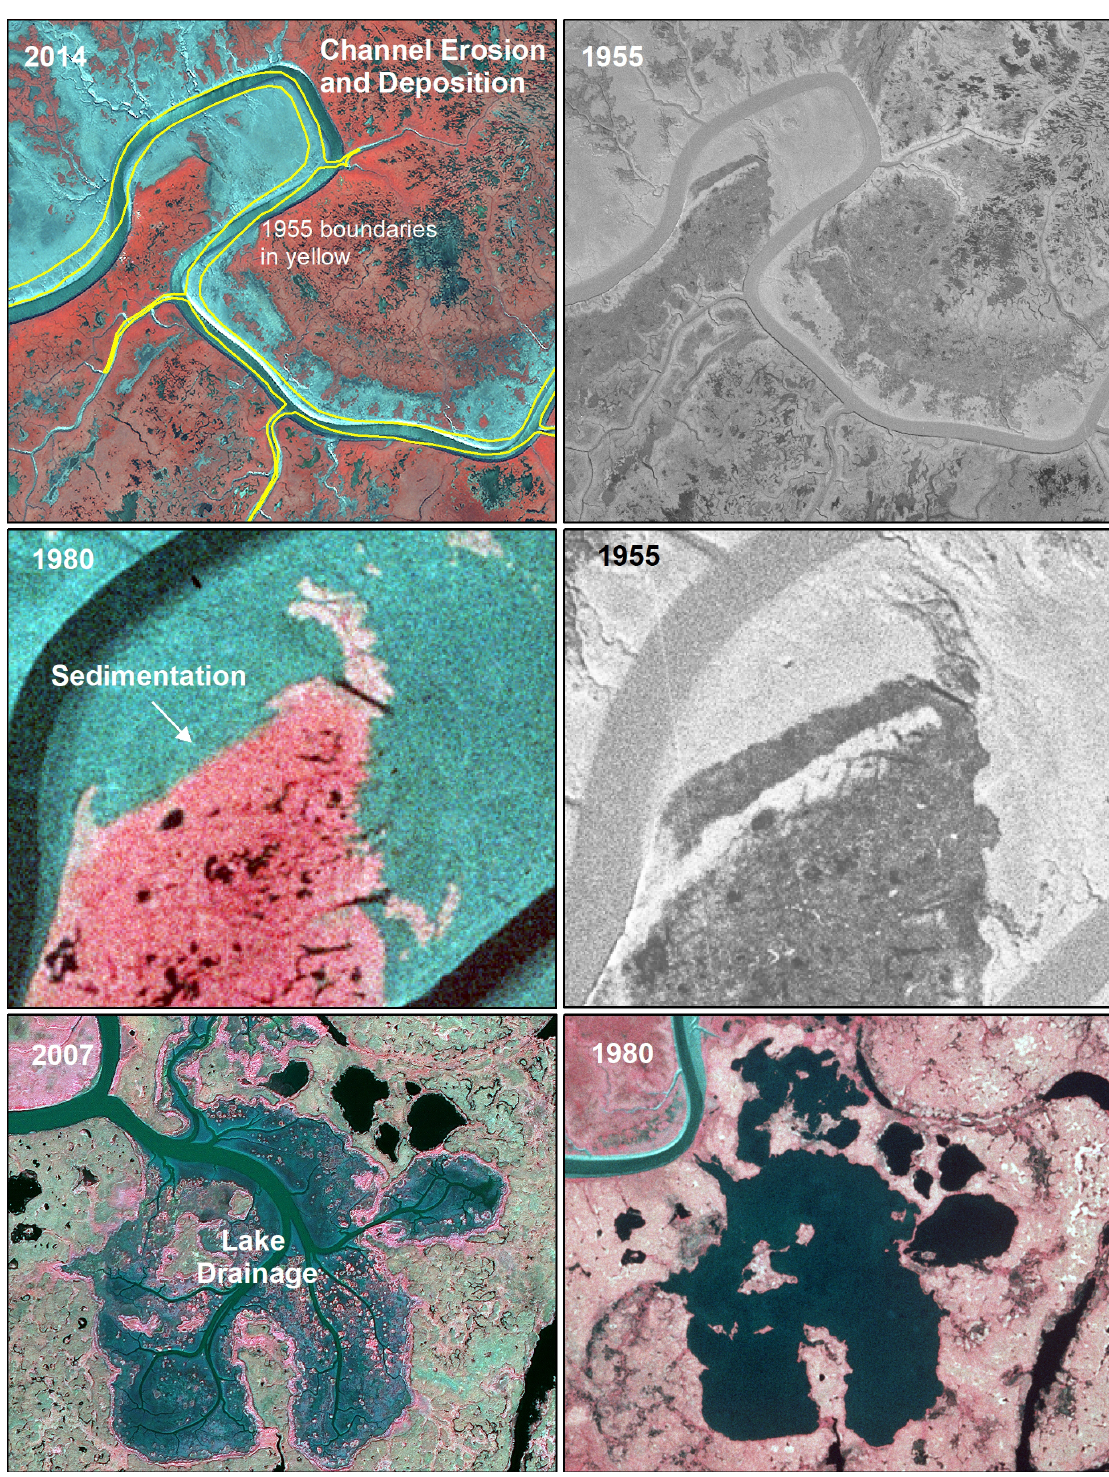
Figure 3. Examples of landscape changes due to channel erosion and deposition, burial of vegetation by sedimentation and lake drainage evident on imagery from 1955, 1980, 2007 and 2014 along the central coast of the Yukon-Kuskokwim Delta. 2014 imagery © Digital Globe, NextView